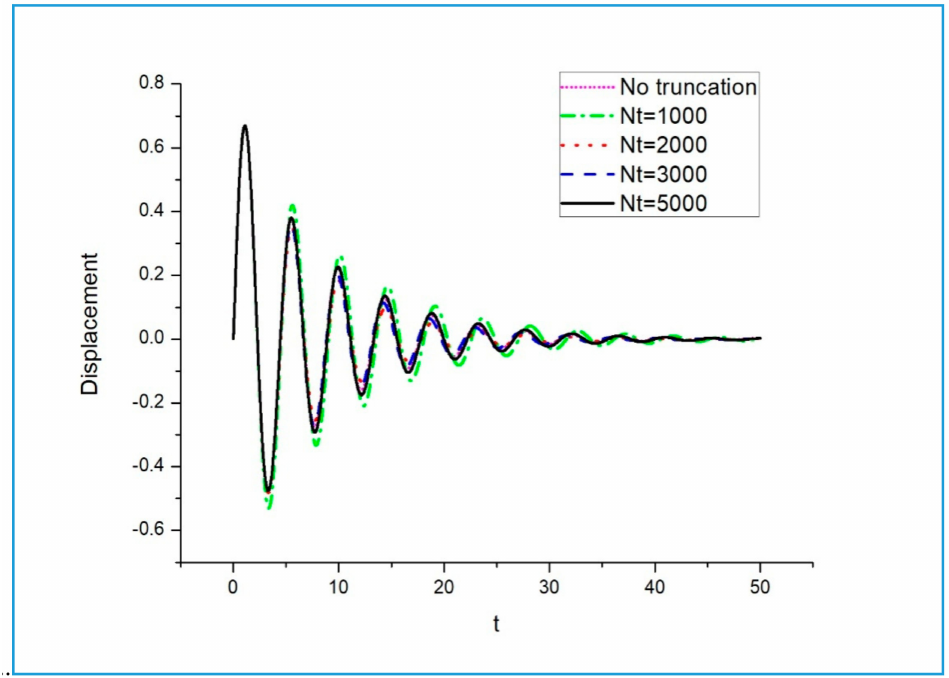
Figure 2. Numerical solutions of original definition method (No truncation) and SMP method ( Nt = 1000, 2000, 3000, 5000) for α =